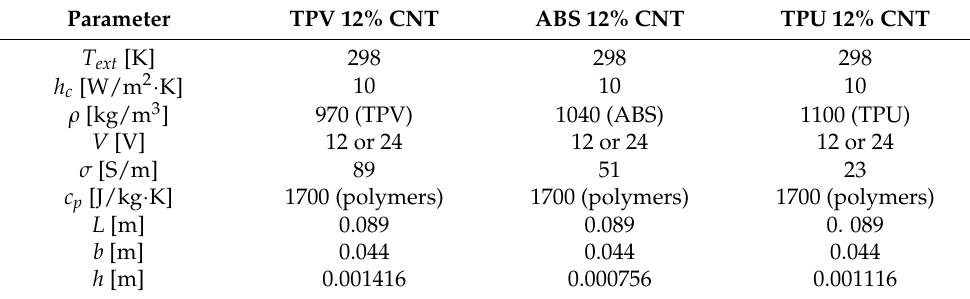
Table 2. Fitting parameters used in analytical model of heating of sheet specimens.